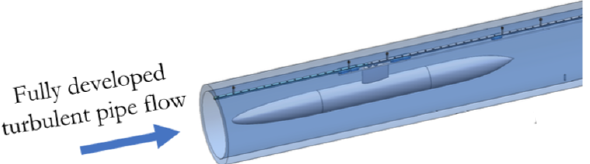
Figure 10. Body of revolution mounted on centerline of pipe. The focus is on the far-downstream recovery of the wake